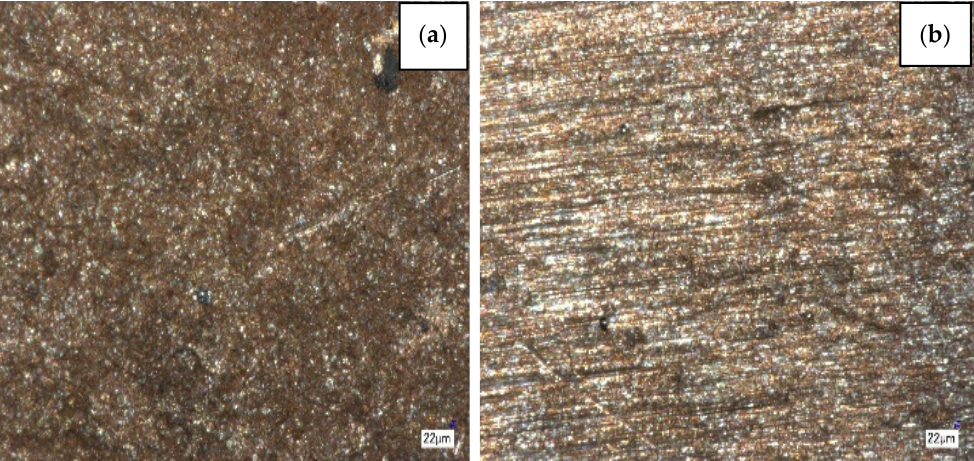
Figure 14. Microstructure of elements based on copper with the inclusion of W-B fibers in a copper matrix ( a , b ).